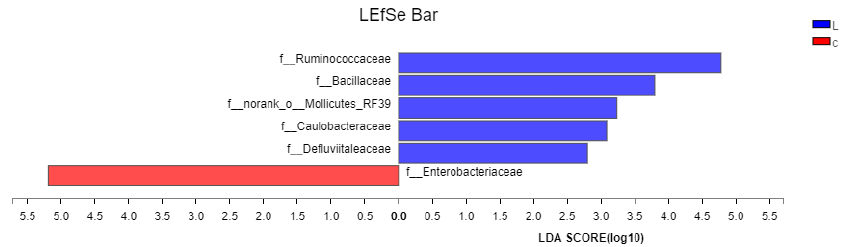
Figure 6. Lefse analysis of intestinal microflora abundance in group L.